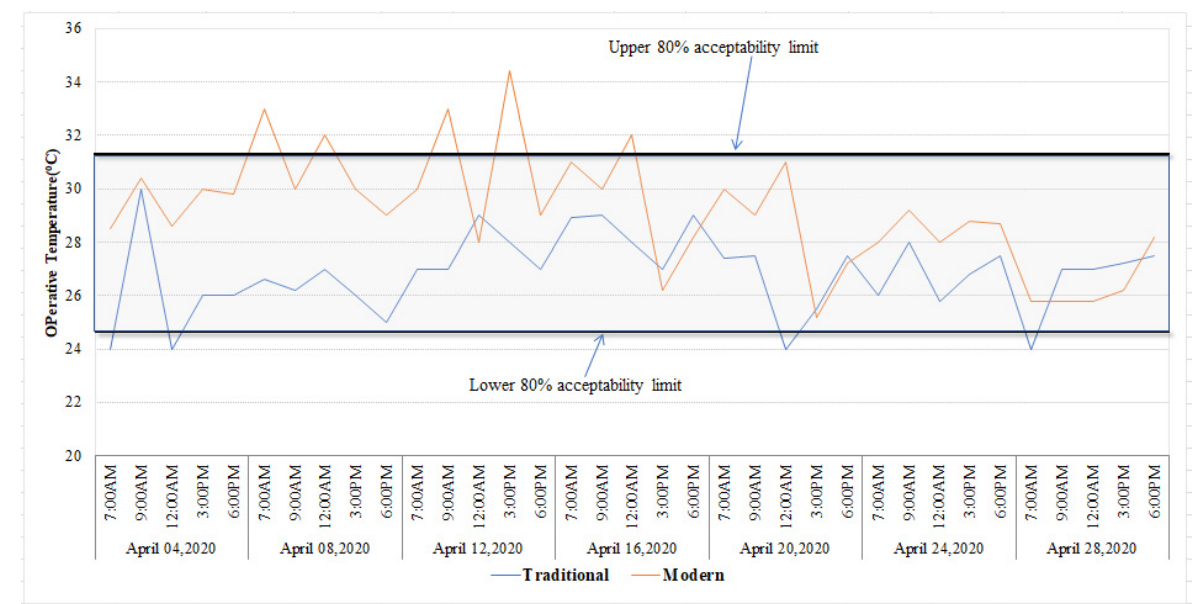
Figure 26. Indoor thermal comfort evaluation from April 2020.